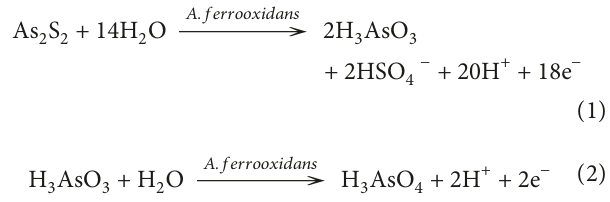
Figure 3: (a) UV-IR extinction spectra of Ag@Au NPs in 6 different solvents: CH C 2 H 5 OH ( n � 1.362), CH 3 (OH)CH 3 CH ( n � 1.3776), and HOCH 2 CH 2 OH ( n � 1.4318). (b) Relationship between the LSPR λ max shift of Ag@ Au core-shell NPs and the refractive index ( n ) of the